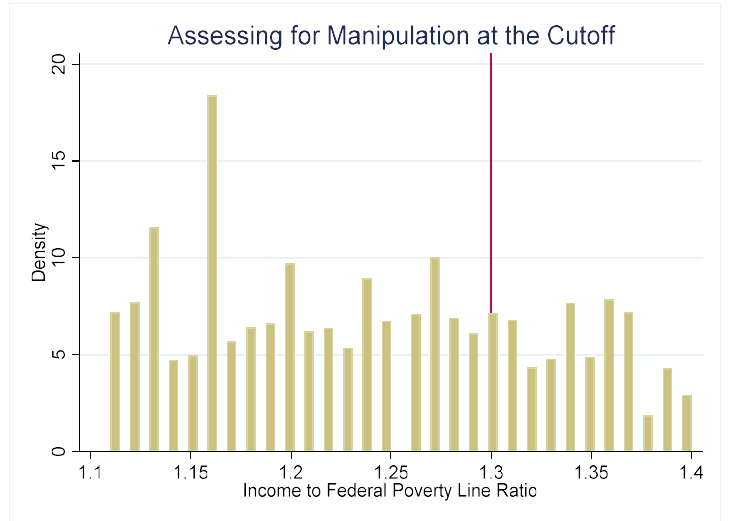
Figure 4. A Closer Look: Assessing for Manipulation at the Cutoff. Notes: Figure 4 plots the density of cases across PIR in a closer examination. This figure suggests that the pattern observed in Figure 3 is a result of a broader pattern, rather than manipulation of income around the cutoff.